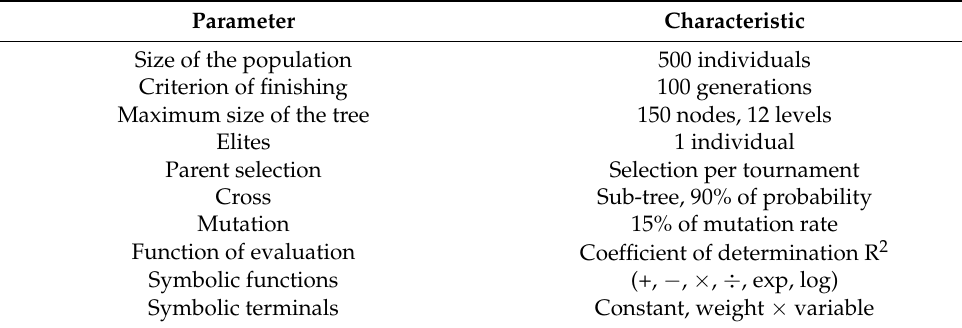
Table 2. Parameters used in modelling with